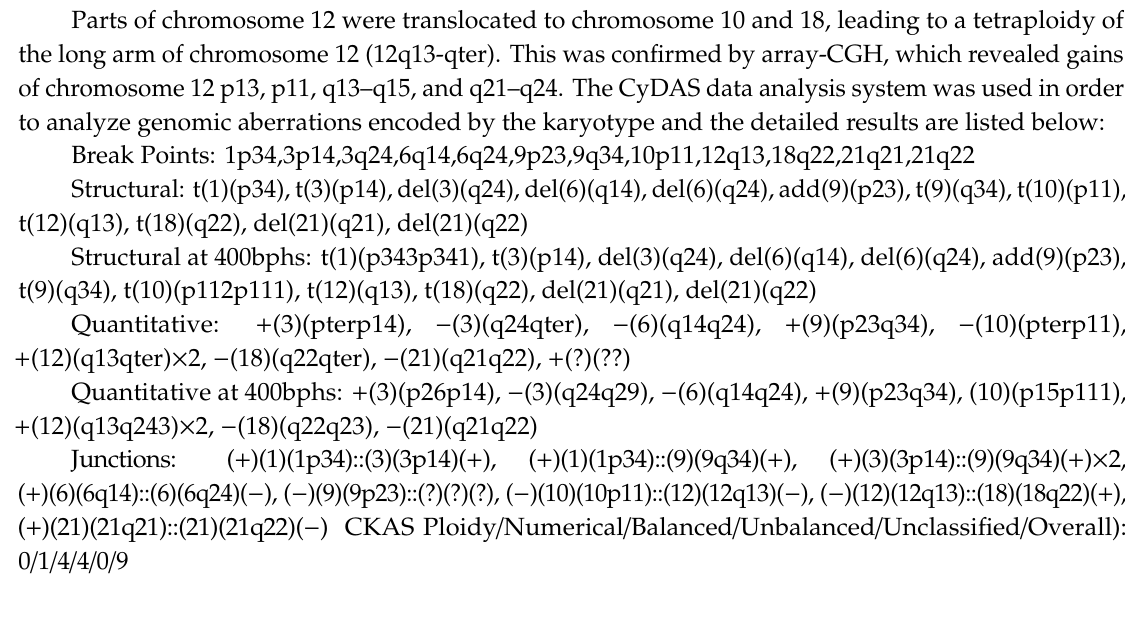
Figure 4. Multi-color fluorescence in situ hybridization (mFISH). 24-color karyotyping of the SRH cell line revealed complex genomic aberrations. White arrows indicate the derivative